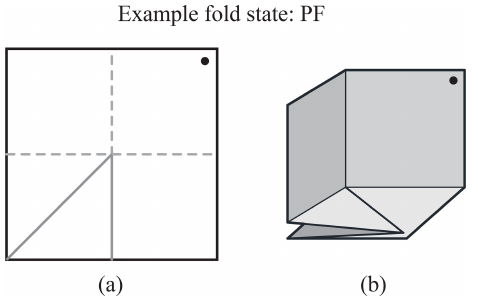
Figure 3. A crease pattern (a) with fold-angle assignment that will result in a mixed fold state (b) . The fold state is a PF fold state with a complete fold-angle set of (90 ◦ , 90 ◦ , 90 ◦ , − 180 ◦ , 180 ◦ ).